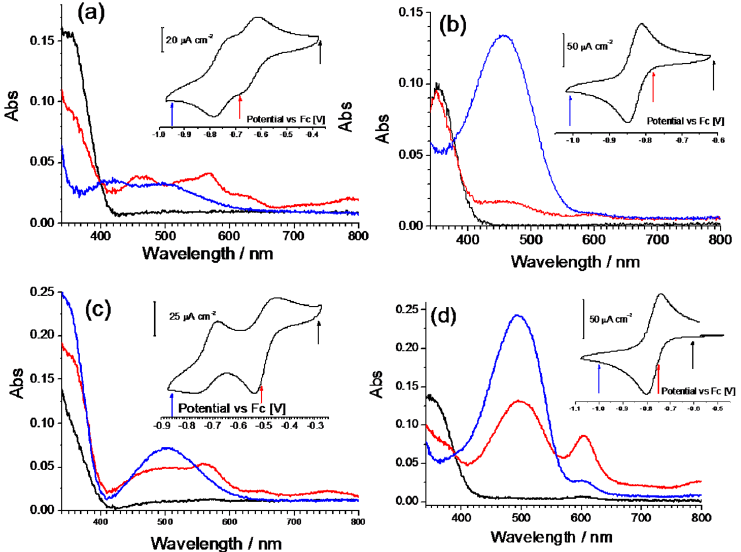
Figure 5. Spectroelectrochemistry of the Q-Q ( a ), iQ-iQ ( b ), Q-(CN)P ( c ) and iQ-Q ( d ) compounds. Spectra were measured at fixed potential corresponding to the points marked in the coefficient of variation (CV) curves (onset). The sequence is: oxidized (black), intermediate (red), and reduced (blue) state.